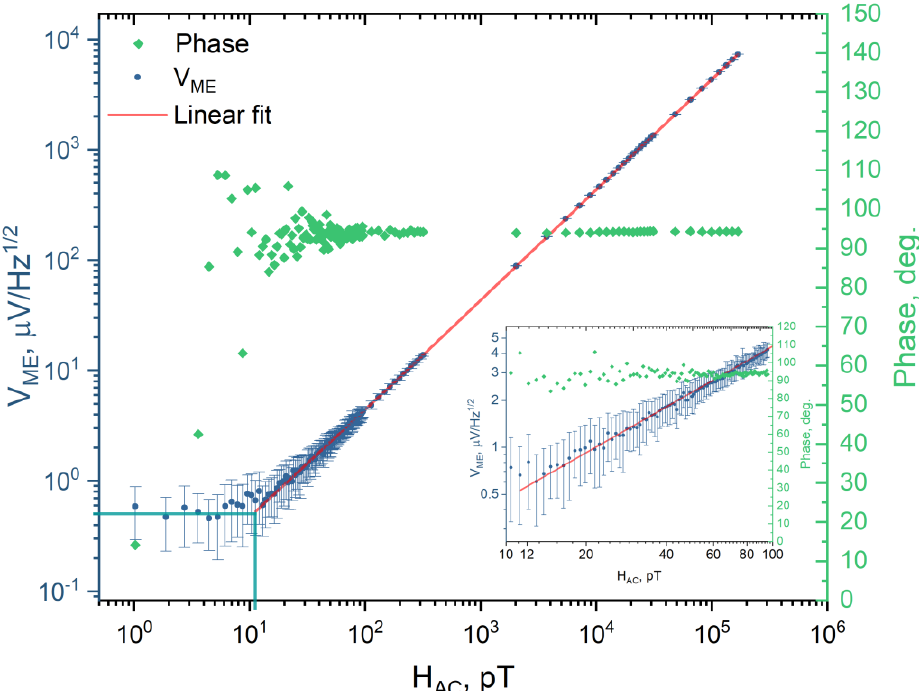
Figure 9. ME voltage (V ME ) and signal phase measured as a function of the AC magnetic field amplitude at the bending resonance frequency (3065 Hz). Error bars indicate the standard deviation for the measured V ME values. The horizontal and vertical straight blue lines show the voltage noise level and magnetic field detection limit, respectively. The inset represents an enlarged portion of the graph in the range from 10 pT to 100 pT.